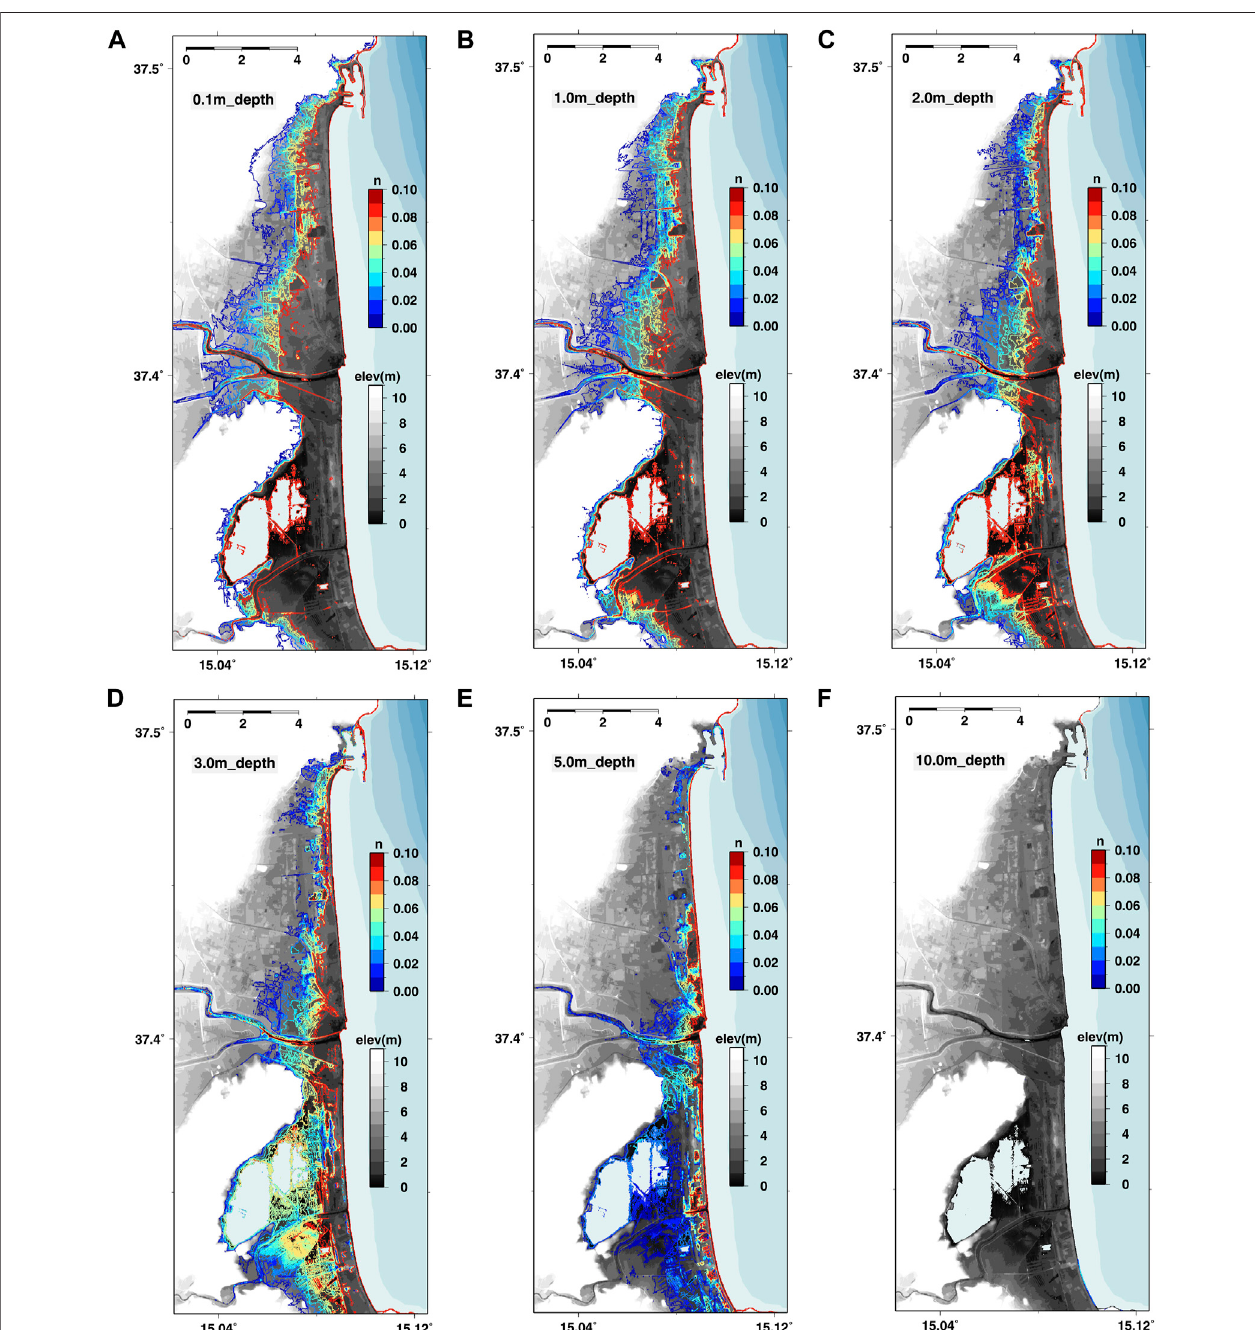
FIGURE 4 | Inundation regions for Catania given earthquake scenario M1 for fl ow depth as indicated for different values of the Manning friction, n. We note that n applies both inonshore andoffshore regionsand thathighninveryshallow offshorewatermay dissipate someenergyinthetsunami beforeitreachestheshore. Panels (A – F) show respectively the maximum extent of inundation for a fl ow depth of 0, 1, 1.0, 2.0, 3.0, 5.0, and 10.0 m.